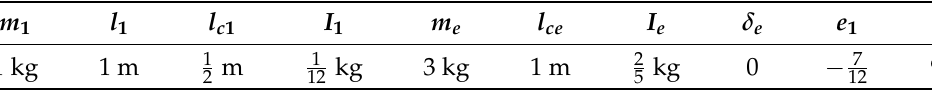
Table 1. Physical parameters of double joint manipulator.